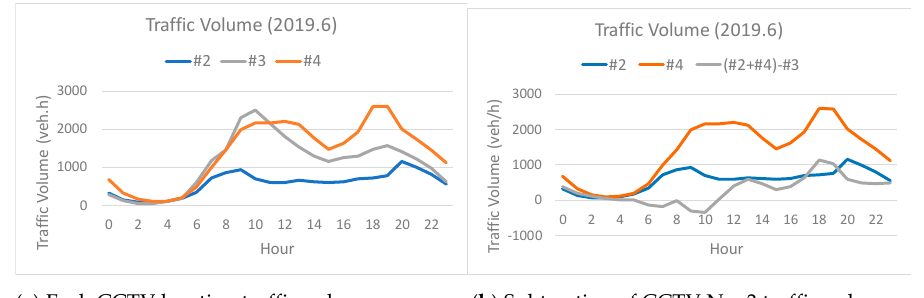
Figure 12. Traffic volume near the CCTV No. 2 location.